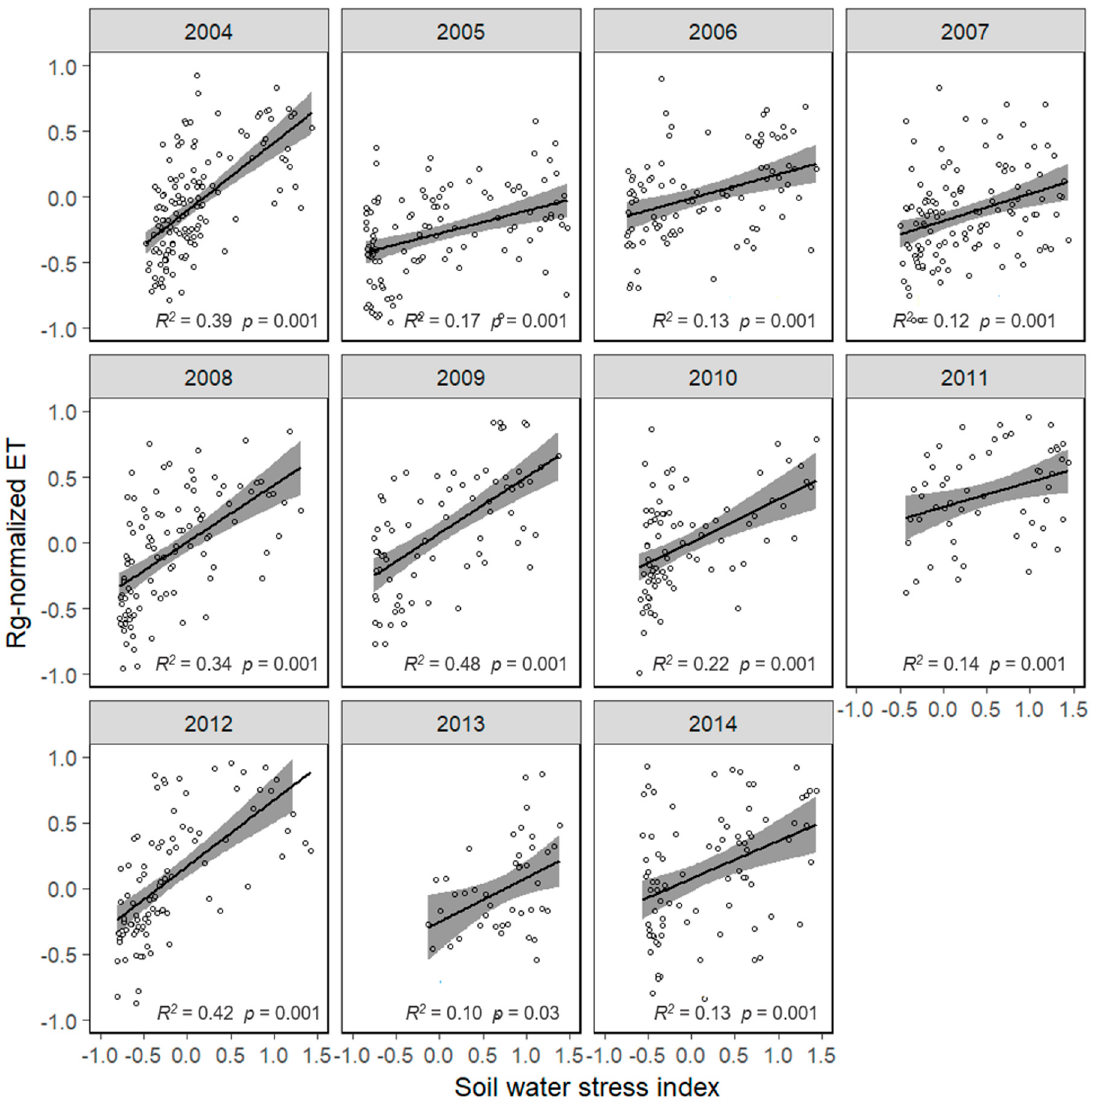
Figure 5. Linear relationship between radiation-normalized evapotranspiration (ET) and soil water stress index (SWSI) during the water depletion period (WD). Gray-shaded regions are the confidence intervals and the black line in between is the linear trend. Each dot corresponds to one day. The greater the SWSI, the lower the soil water stress.